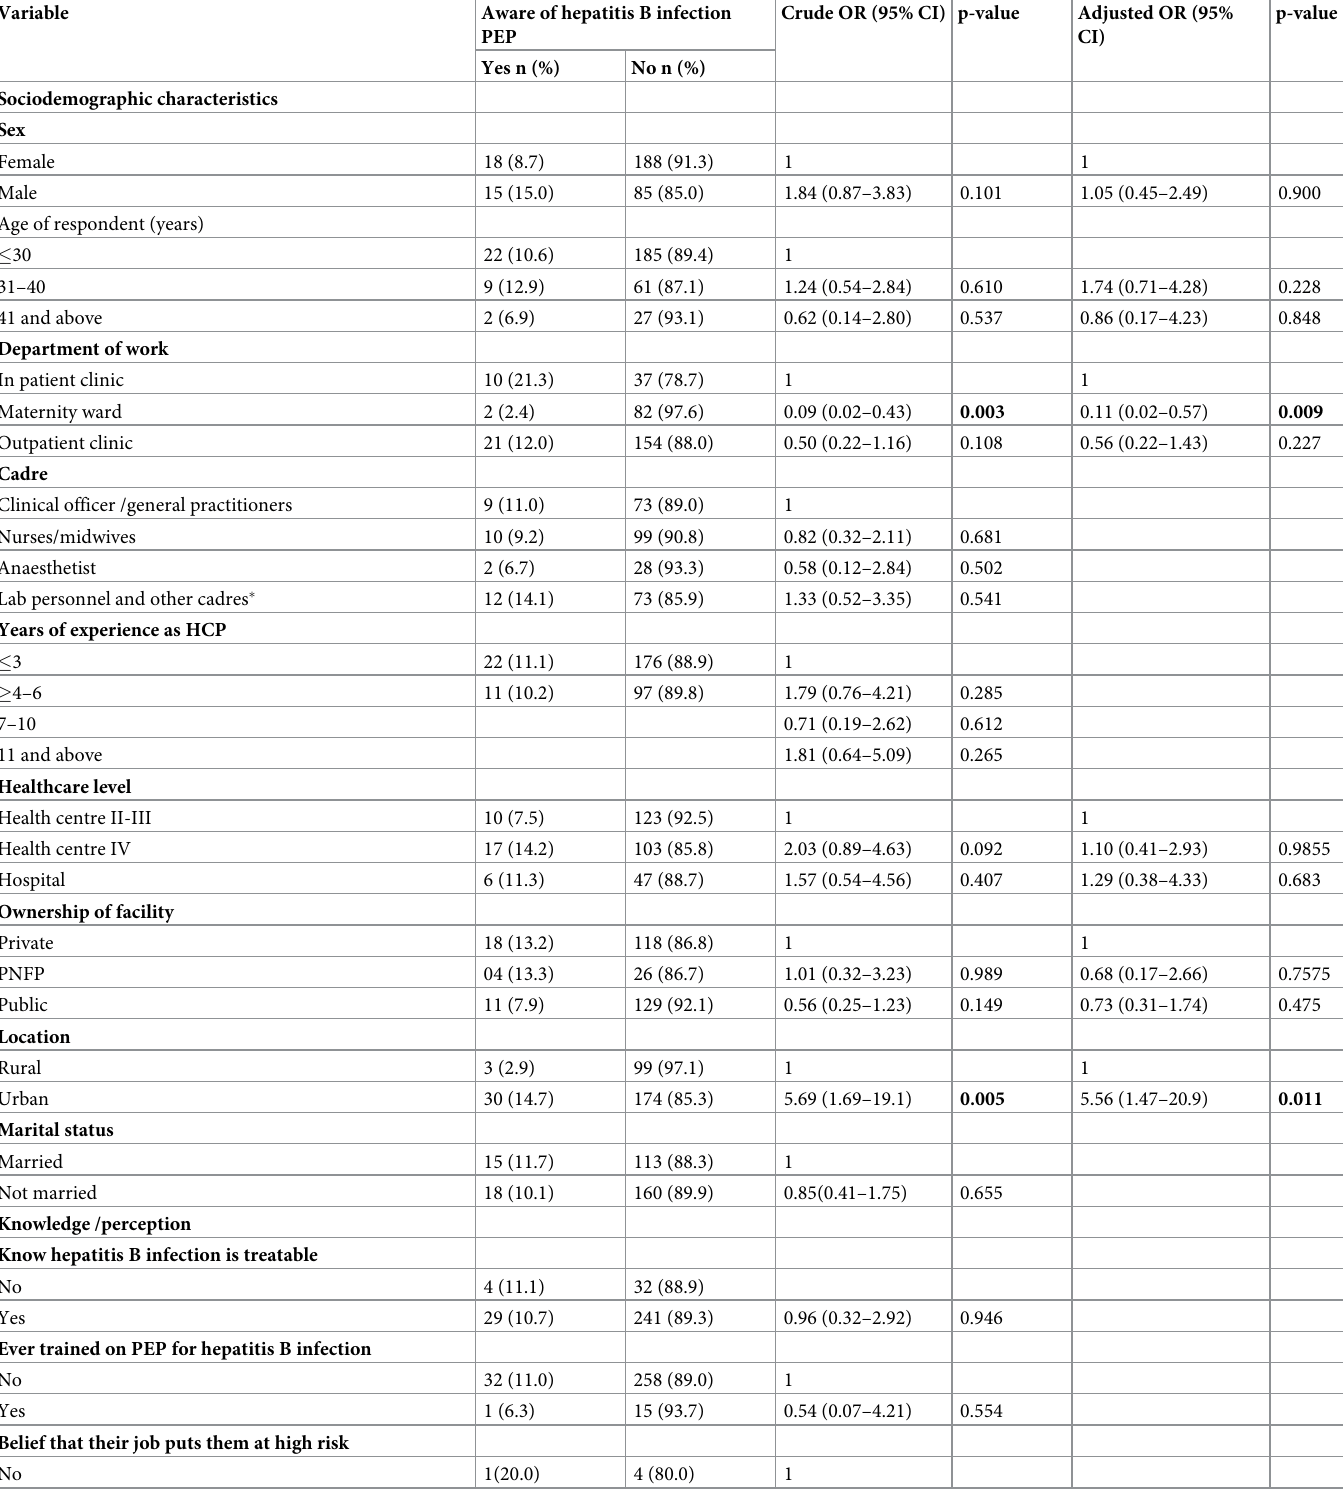
Table 4. Factors associated with awareness of hepatitis B infection post exposure prophylaxis among healthcare providers in Wakiso district,